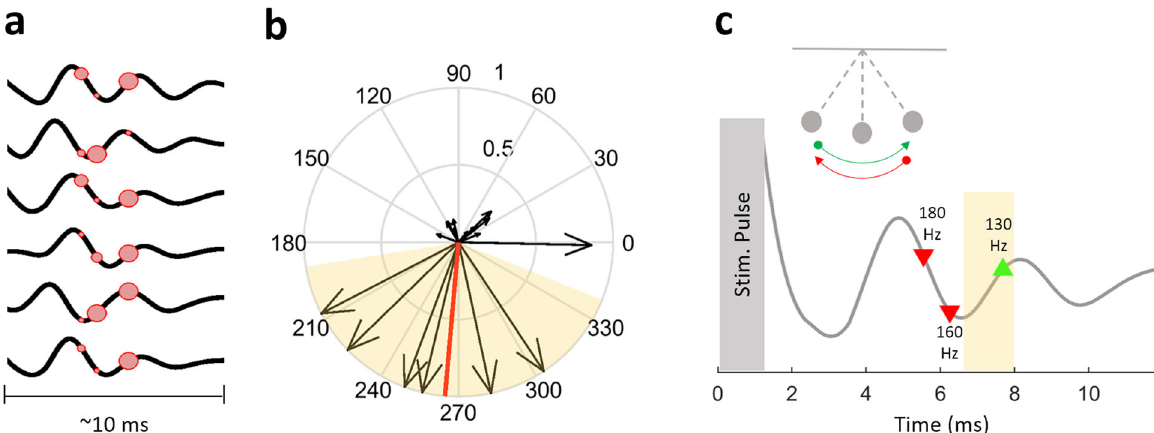
Fig. 7 The DBS can be tuned to provide maximum modulatory effect based on the phase of ECA waveform. a The ECA waveforms after 22 s of low- frequency stimulation from the six subjects with both 20 Hz and high-frequency stimulation experiments. The location of the red circles denotes where the next 130, 160, and 180 Hz stimulation pulses would be, if the stimulation continued with the speci fi ed frequency. The size of the circle denotes the relative amplitude of the induced HFO by that stimulation. b The information in a is presented on polar coordinates to illustrate the phase preference. The arrow length denotes the relative amplitude of the induced HFO power. The mean angle was 265° and is denoted by the red line. The preferred phase was between 189° and 338° ( n = 6) and is denoted by the highlighted background. c A pendulum and a representative ECA waveform to illustrate the swing- like behavior of the evoked response. The shaded region illustrates the preferred phase angles from panel b . The timings of 130, 160, and 180 Hz stimulus pulses are marked as well. When the next stimulation pulse is at a preferred phase location (forward motion, green), the modulatory effects can be enhanced. On the other hand, stimulating at the other phase (backward motion, red) could hinder effect of